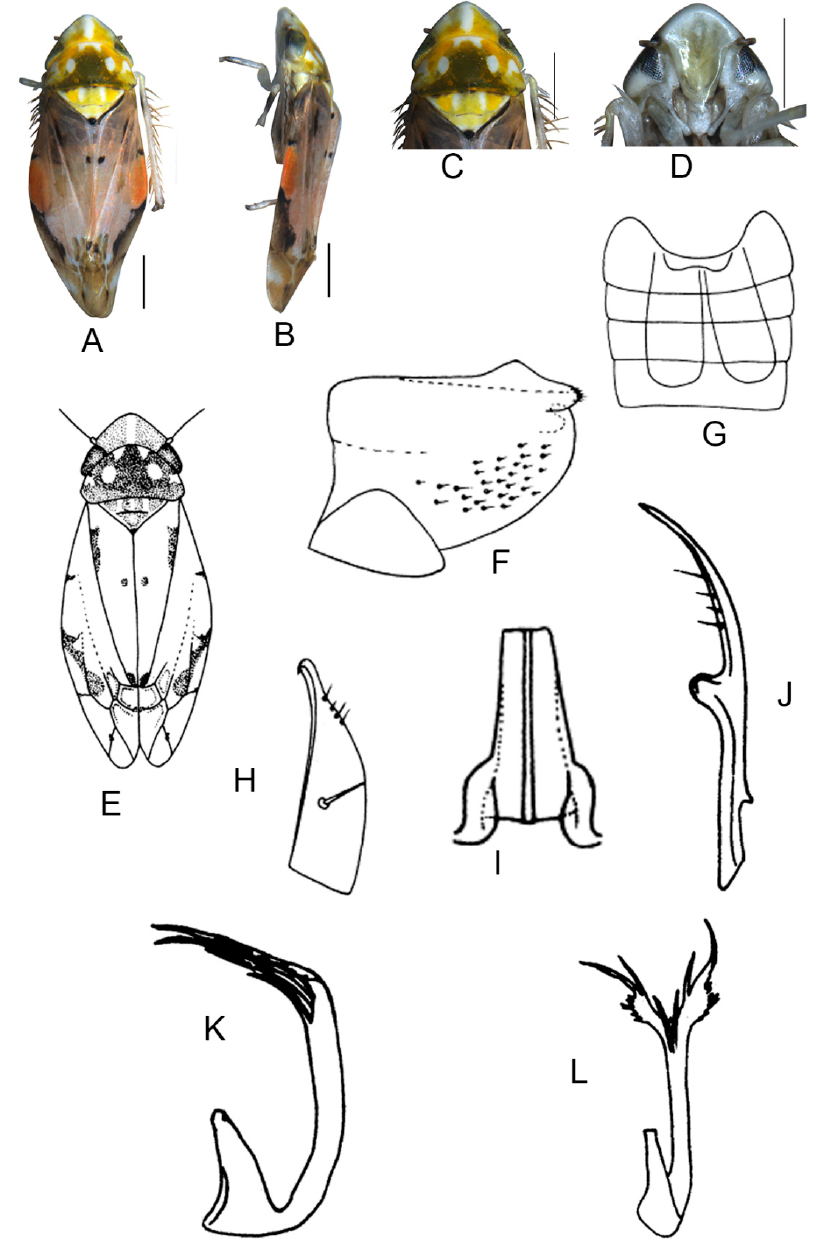
Figure 20. Eurhadina ( Singhardina ) spinifera ( E – L : Huang et Zhang, 1999 [8]): ( A ) habitus, dorsal view; ( B ) habitus, lateral view; ( C ) head and thorax, dorsal view; ( D ) face; ( E ) habitus, dorsal view; ( F ) male pygofer side, lateral view; ( G ) abdominal apodemes, dorsal view; ( H ) subgenital plate, dorsal view; ( I ) connective, dorsal view; ( J ) paramere, dorsal view; ( K ) aedeagus, lateral view; and ( L ) aedeagus, posterior view. Scale bars: 0.5